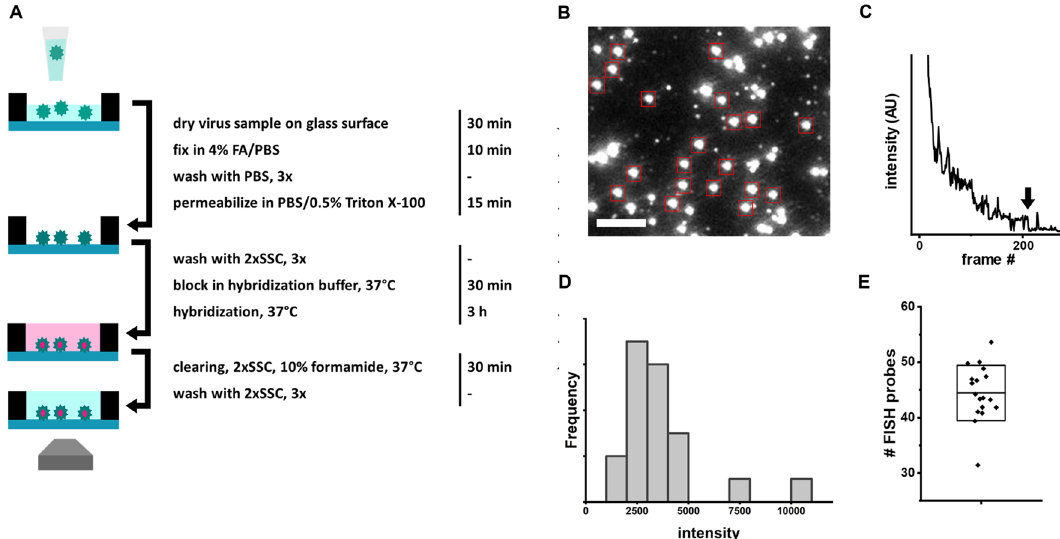
Figure 1. Efficiency of FISH in free virus particles. ( A ) Schematic depiction and summary of the standard FISH based virus detection protocol with incubation times for the individual steps 35 . ( B ) Representative field of view with influenza A/WSN/33 virus particles (10 6 PFU/mL) stained by an array of 48 fluorescent hybridization probes. Red boxes: Diffraction-limited, isolated particles that were analyzed by stepwise photobleaching. Scale bar 3 µm. ( C ) Representative photobleaching curve recorded to determine the average number of probes